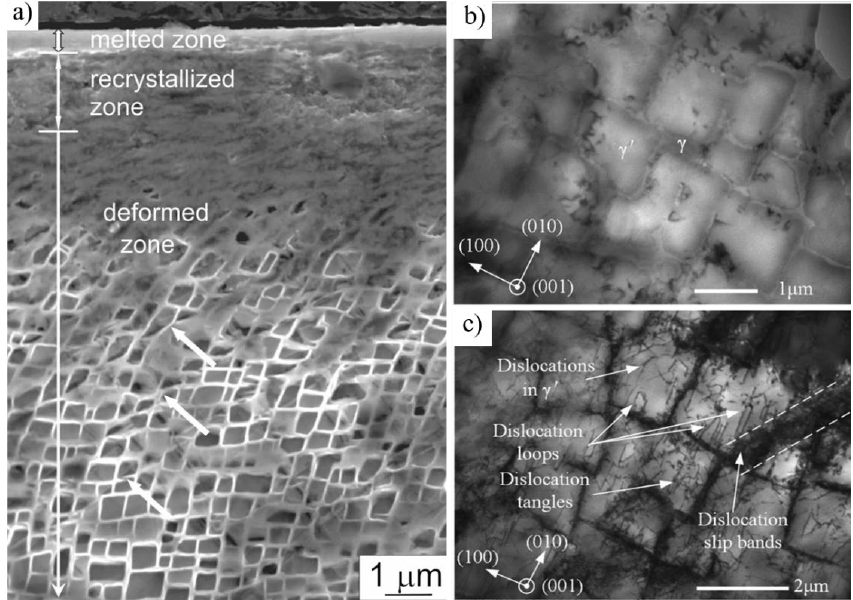
Figure 5. ( a ) SEM micrograph of LPed single crystal Ni-based superalloy CMSX-4 showing the melted, recrystallized, and deformed zones reprinted from [58]. TEM micrographs of the microstructure both prior ( b ) and following ( c ) LP ~5 GW/cm 2 showing several dislocation configurations. Reprinted from [45] with permission from Elsevier.